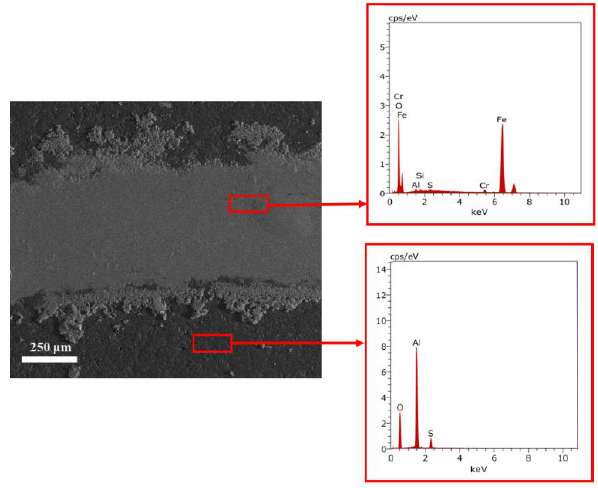
Figure 10. Backscattered electron (BSE) image of the GHA10/100Cr6 wear track with the microanalysis spectrum of the selected track area ( top ), and of the alumina coating ( bottom ).